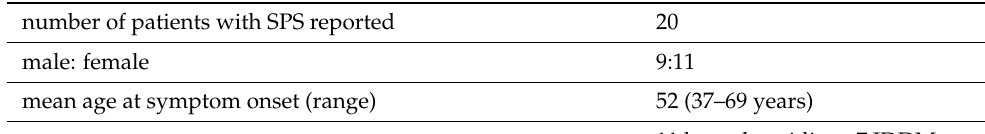
Table 1. Clinical characteristics, investigations and outcomes of 20 patients with stiff person